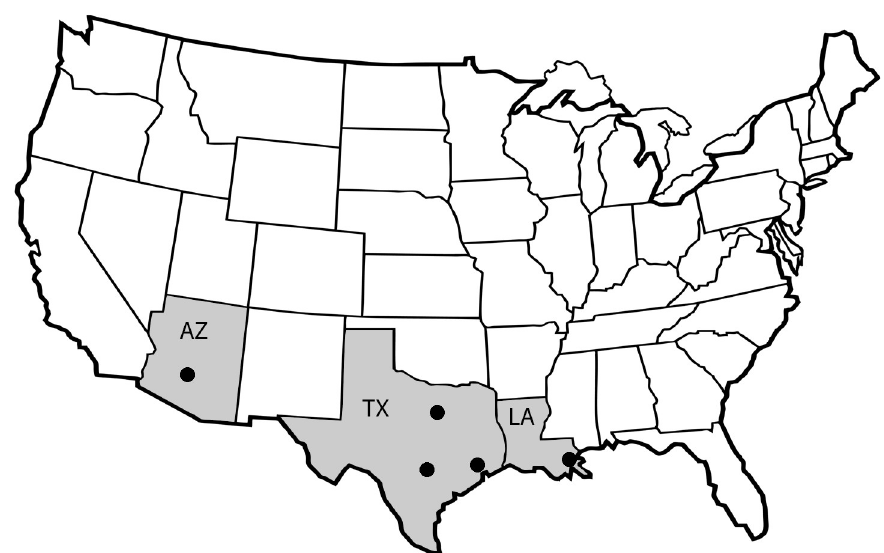
Fig 1. Map showing Culex quinquefasciatus egg raft collection sites in the southern U.S. See Table 1 for details. Reprinted under a CC BY license with permission from David S. Carlson, creator, original copyright 2018.